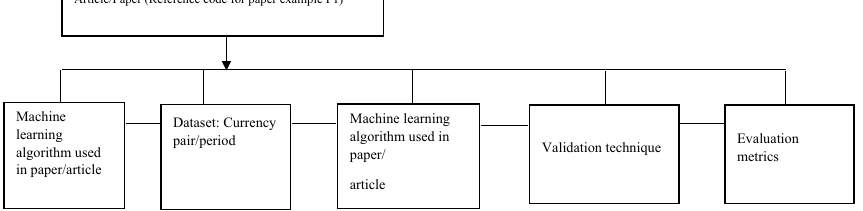
Fig. 2 Showing conceptual framework for data extraction from the primary